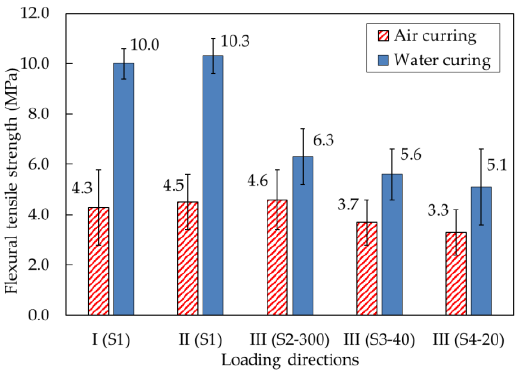
Figure 19. Comparison of the flexural tensile strengths of mortar samples produced under different curing conditions.